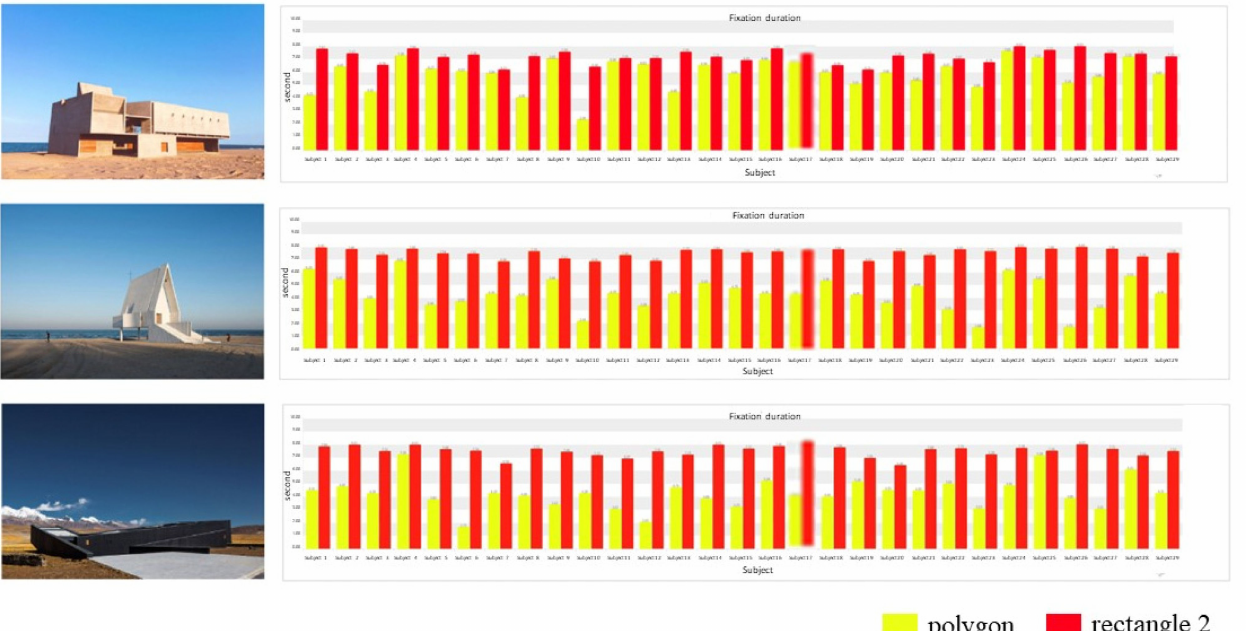
Figure 5. Fixation durations of the experiment